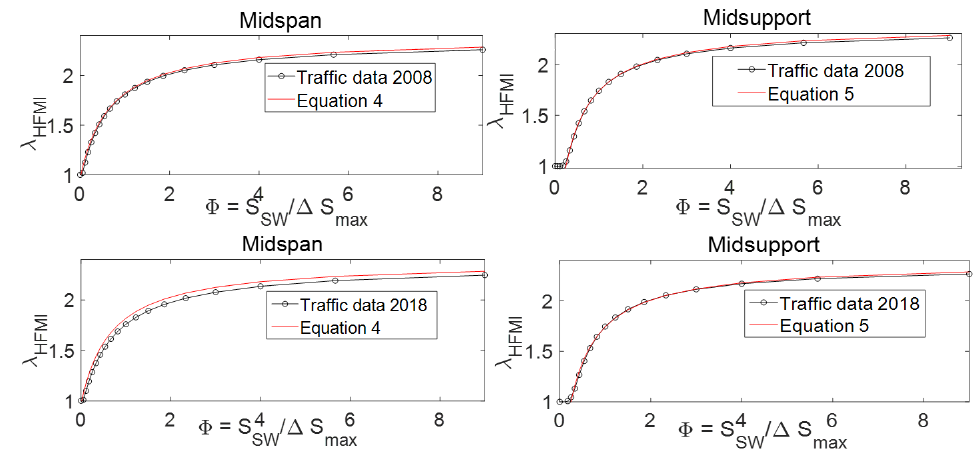
Figure 8. Comparison of Φ – λ HFMI curves calculated using the Dutch traffic data and Equations (4) and (5) for the mid-span and mid-support sections,